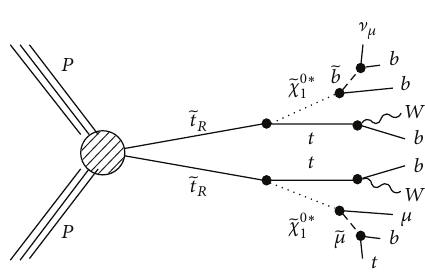
Figure 6: Signal process for stop-pair production with LSP decays mediated via 𝜆 󸀠 233 (from [41]).